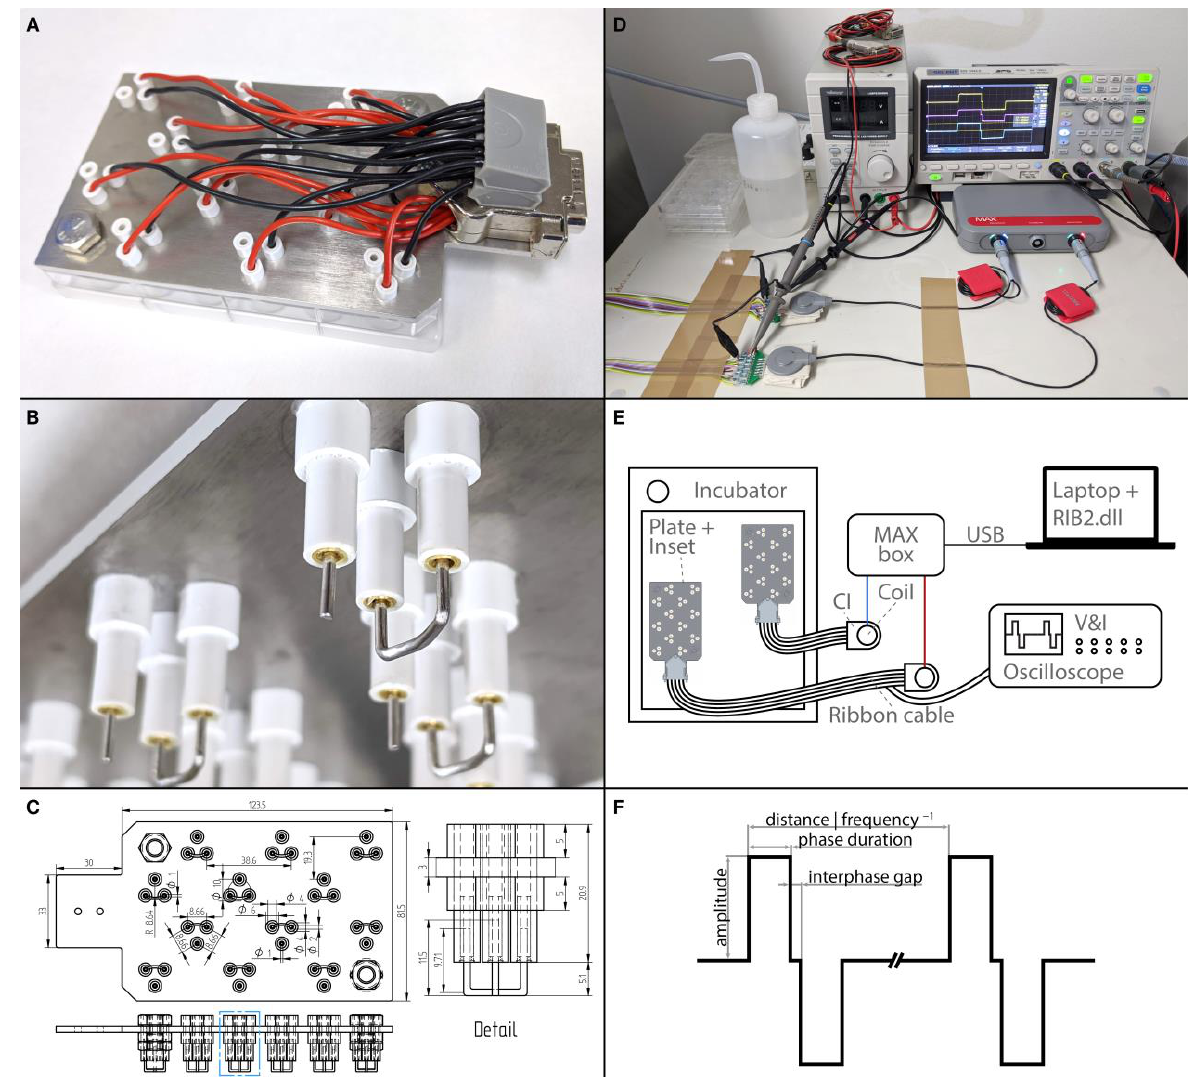
Figure 11. Electrical stimulation setup. ( A ) Photograph of the electrode inset in a 24-well plate. A set of electrodes is situated within every second well. ( B ) Detail of the lower part of the electrode inset. Three electrode holders fit into one well. The long and thin tubes are fixed by shorter and wider tubes above (not visible) and below the metal plate. In each holder sits a gold-plated socket that is soldered to a wire. The sockets hold the curved reference electrode as well as the stimulation electrode. ( C ) Multiview projections (top and side) and dimensions of the base plate, electrode holders, and platinum wires. The detail shows an enlargement of the features within the blue dotted box. Photograph ( D ) and schematic drawing ( E ) of the stimulation setup. Shown are two CI stimulators connected via coil transmitters to a MAX box. An oscilloscope monitors the voltage and current of the signal. Two ribbon cables lead into the incubator and are connected to the stimulation insets. ( F ) Schematic illustration of the stimulation signal and its main parameters.